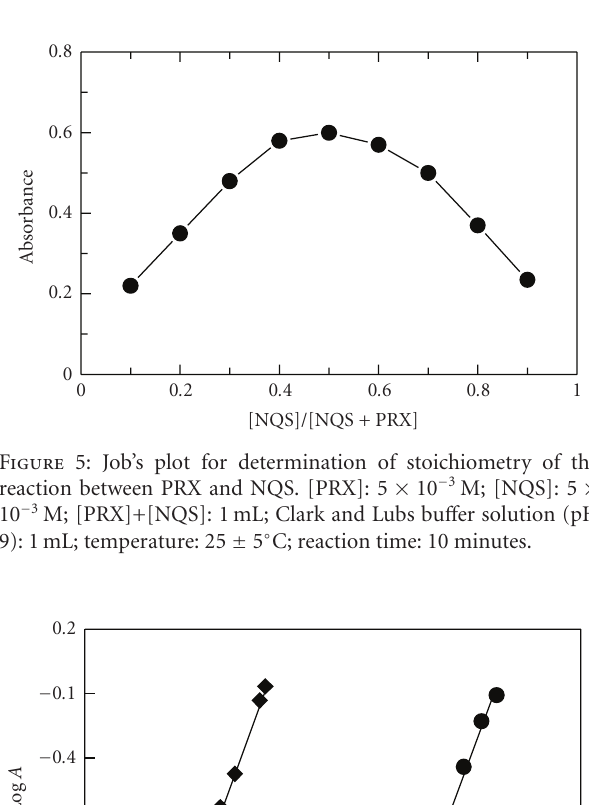
Table 3: Analysis of PRX in presence of common excipients by the proposed